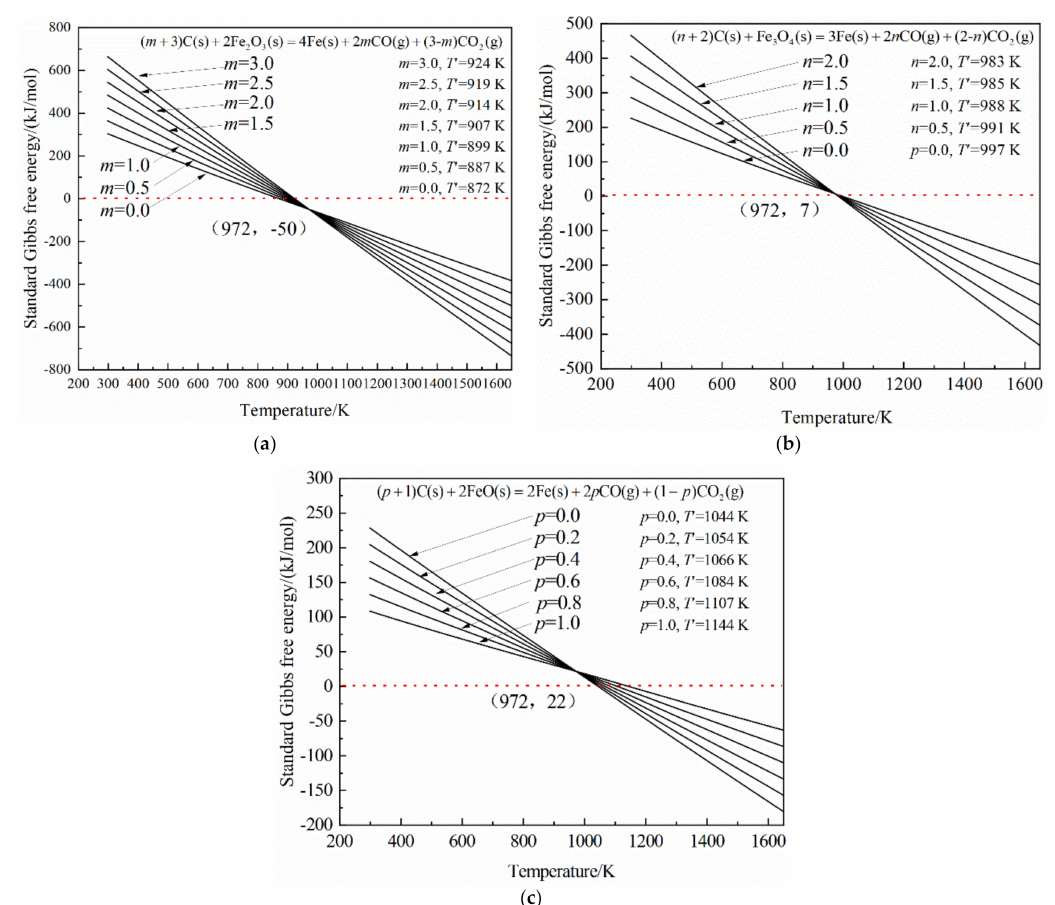
Figure 9. The standard Gibbs free energy as a function of temperature: ( a ) the reaction of ( m + 3)C(s) + 2Fe 2 O 3 (s) = 4Fe(s) + 2 m CO(g) + (3 − m )CO 2 (g) ( m = 0.0, 0.5, 1.0, 1.5, 2.0, 2.5, 3.0); ( b ) the reaction of ( n + 2)C(s) + Fe 3 O 4 (s) = 3Fe(s) + 2 n CO(g) + (2 − n )CO 2 (g) ( n = 0.0, 0.5, 1.0, 1.5, 2.0); ( c ) the reaction of ( p + 1)C(s) + 2FeO(s) = 2Fe(s) + 2 p CO(g) + (1 0.4, 0.6, 0.8,